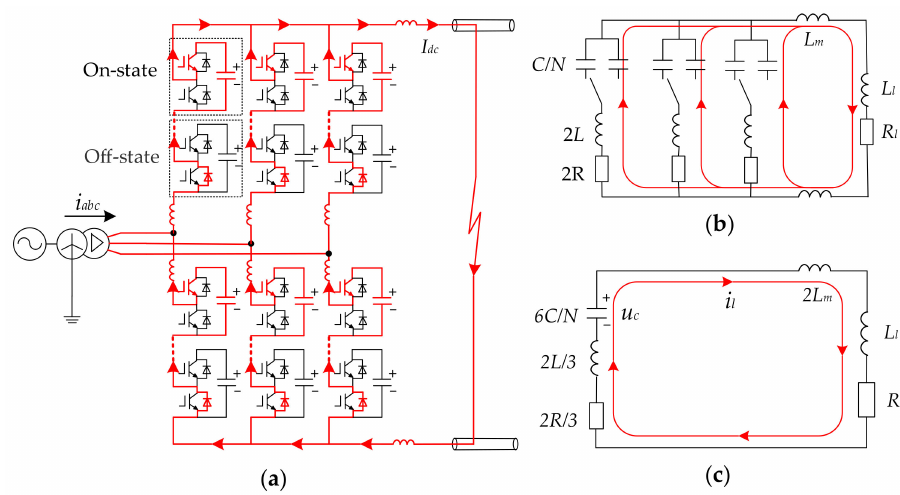
Figure 3. MMC-HVDC system pole-to-pole fault (PPF) circuit. ( a ) Detailed fault circuit; ( b ) equivalent fault circuit; ( c ) simplified fault